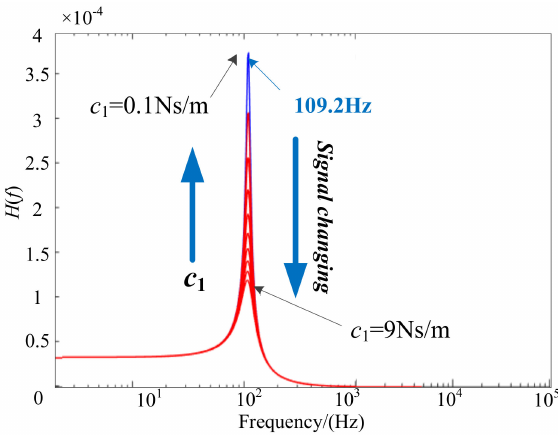
Figure 5. Effects of c 1 on the frequency response of the plastic box.